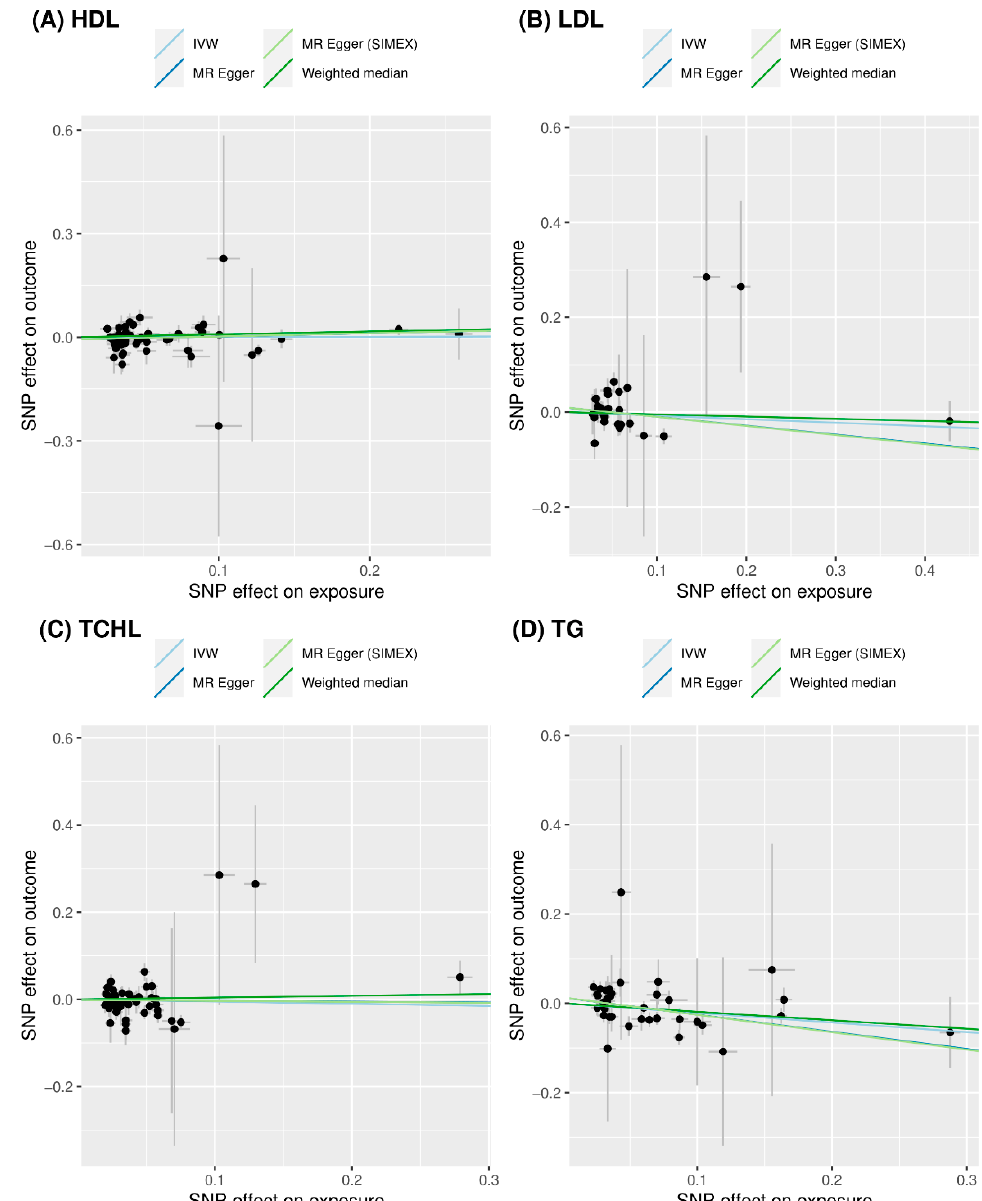
Figure 4. Scatter plots of MR tests assessing the effect of dyslipidemia on T2D. ( A ) Causal effect of HDL on T2D; ( B ) causal effect of LDL on T2D; ( C ) causal effect of TCHL on T2D; and ( D ) causal effect of TG on T2D. The dots represent the effect sizes ( β ) of each SNP on dyslipidemia ( x -axis) and T2D ( y -axis), and the grey lines show their standard errors. Regression slopes show the estimated causal effect of dyslipidemia on T2D. The light blue, dark blue, light green, and dark green regression lines represent the IVW, MR-Egger, MR-Egger (SIMEX), and weighted median estimate, respectively. MR: Mendelian randomization; T2D: type 2 diabetes; HDL: high-density lipoprotein cholesterol; LDL: low-density lipoprotein cholesterol; TCHL: total cholesterol; TG: triglycerides; SNP: single nucleotide polymorphism; IVW: inverse ‐ variance weight; SIMEX: simulation extrapolation.